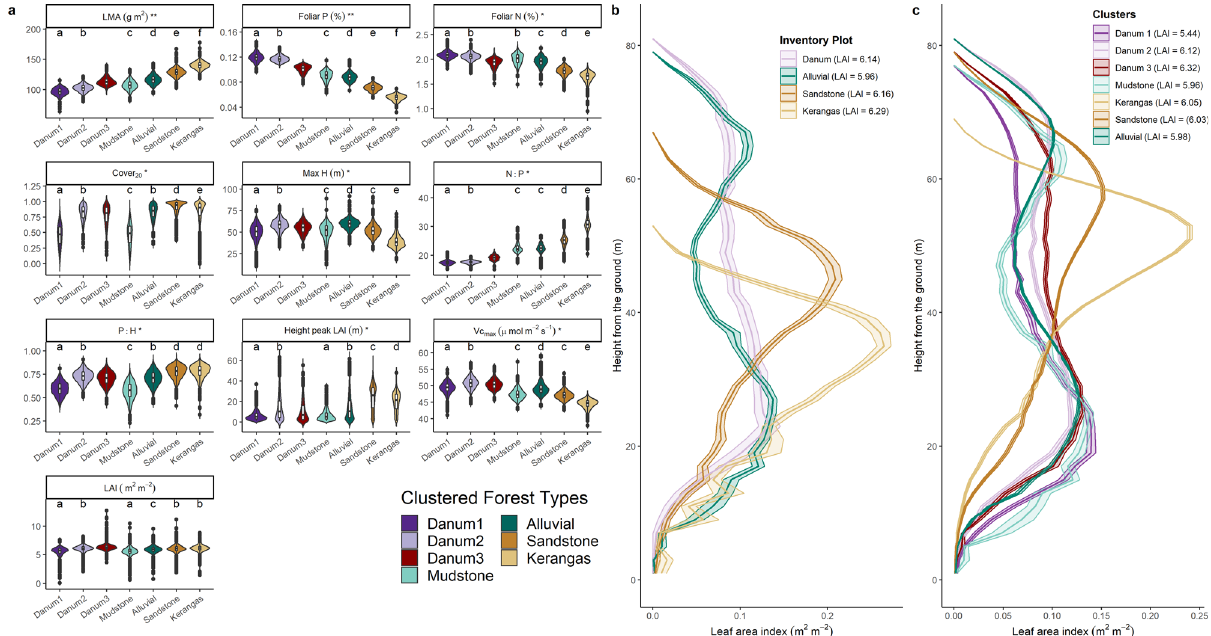
Fig. 3 Canopy trait and structural attribute distributions. Trait distributions by cluster for Sepilok k = 4 and Danum k = 3. Forest types are ordered based on their median leaf mass per area (LMA) to illustrate differences in traits for forest types that vary along the leaf economics spectrum. Identical letters represent clusters where there is no signi fi cant difference between forests based on one-way ANOVA tests ( p < 0.01). ** = traits that varied signi fi cantly between all seven forest types. * = traits that varied signi fi cantly between at least fi ve forest types ( a ). Vertical leaf area index (LAI) pro fi les for all pixels within each inventory plot ( b ) and forest types identi fi ed based on k = 3 clusters at Danum and k = 4 clusters at Sepilok ( c ). Shading around lines in b , c indicate 95% con fi dence (Fig. 5). Clustering with LMA, leaf P, Cover 20 , and maximum height properties were used (overall accuracies (OA) of 96.0% and 86.0% for k = 2 and k = 4 respectively) at Sepilok (Fig. 5a; Supplementary